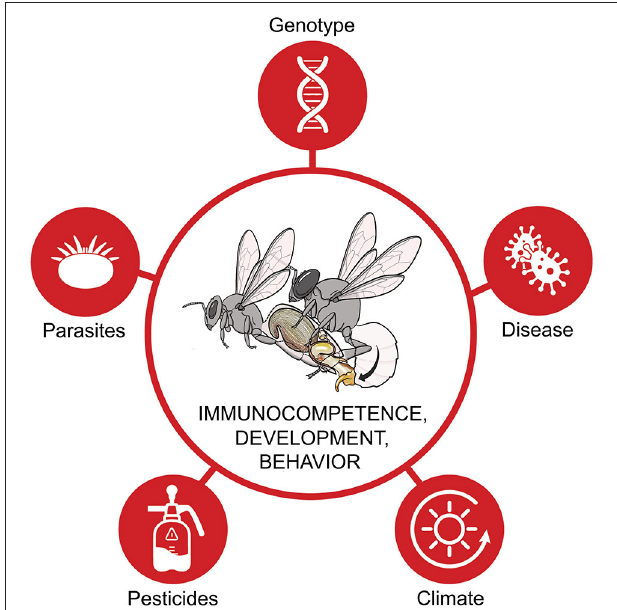
FIGURE 1 | Factors affecting insects’ abilities to survive and reproduce. Research in this special issue addresses how parasites, genetics, diseases, climate change, pesticides, and, in some cases, their interactions, can impact insect lifespan and fertility. Other factors, such as competition and habitat loss, are also important but are not addressed here. Artist: Kirsten